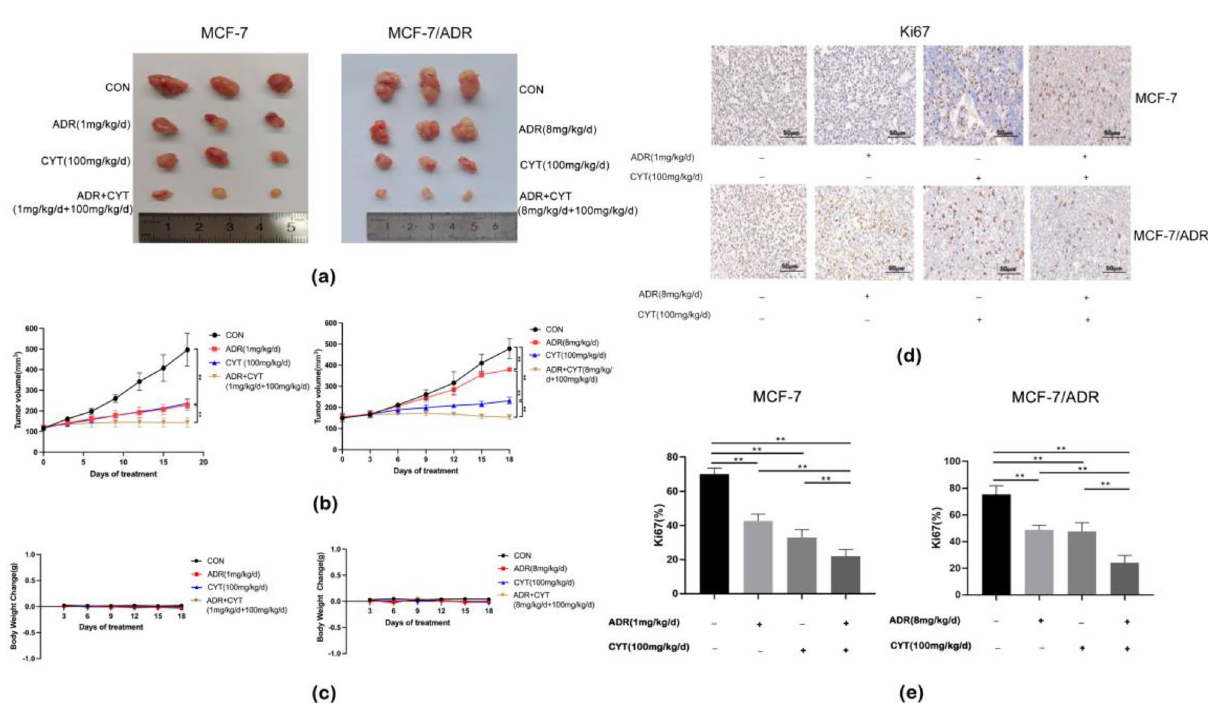
Figure 5. Anti-tumor effects of ADR + CYT on MCF-7 and MCF-7/ADR xenograft tumor model. ( a ) The photographs of tumors of MCF-7 and MCF-7/ADR after treatment with saline, ADR, CYT, and ADR + CYT. ( b ) Tumor volume was measured in different time intervals using a vernier caliper and calculated. ( c ) Body weight change of all groups. ( d ) The expression of Ki67 was detected by immunohistochemistry. ( e ) Data were expressed as mean ± S.D. ** p <